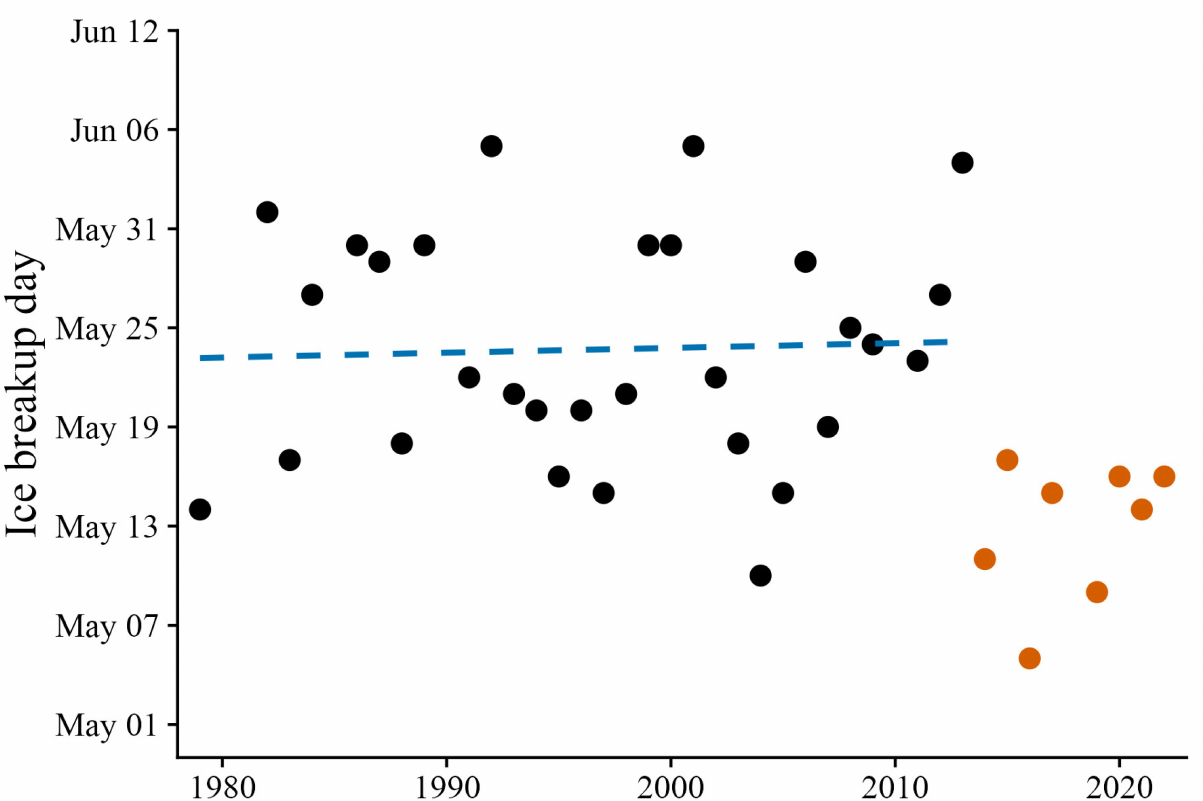
Figure 2. Annual river ice breakup dates for the Yukon River near Emmonak. Orange circles indicate the study years. Blue dashed line shows the trend from